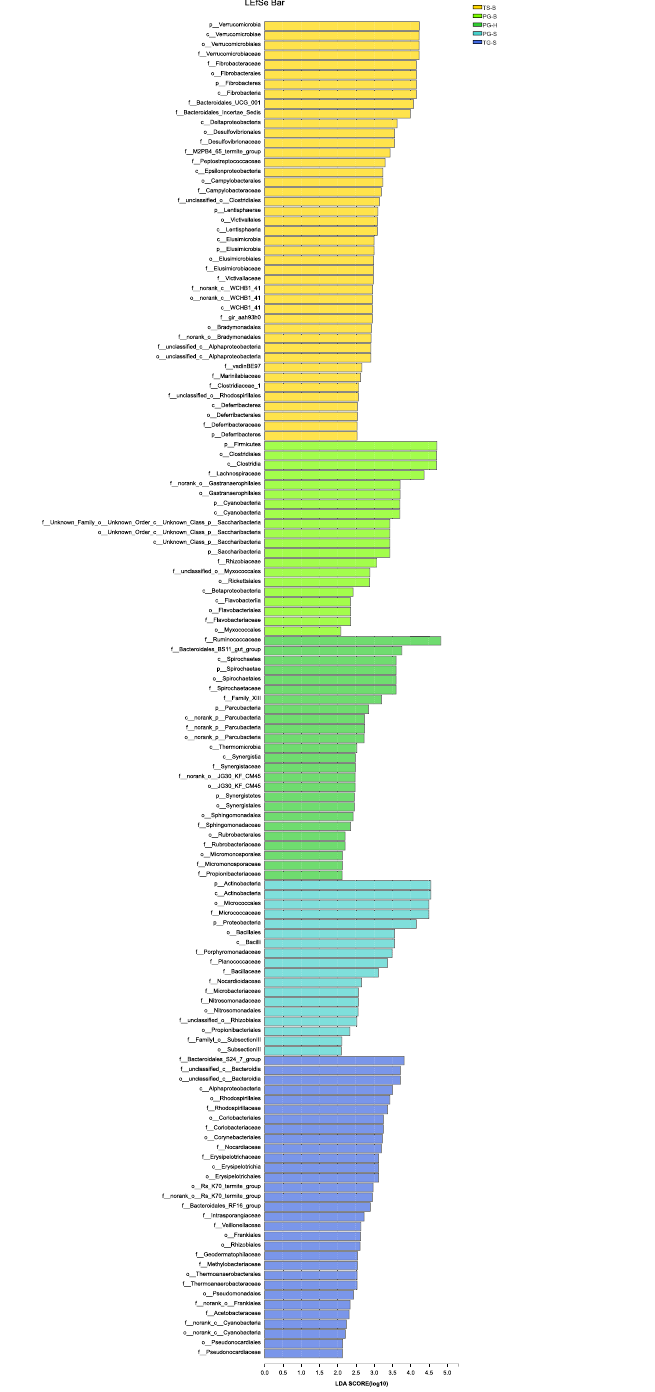
FIGURE 8 | The phyla to families that contribute to the differences among populations identified by